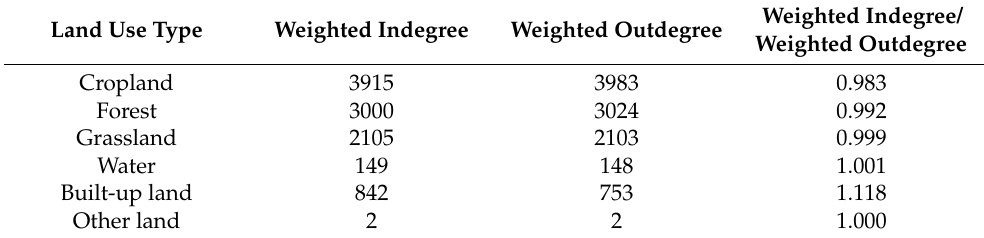
Table 6. Weighted indegree and weighted outdegree from 1990–2000.